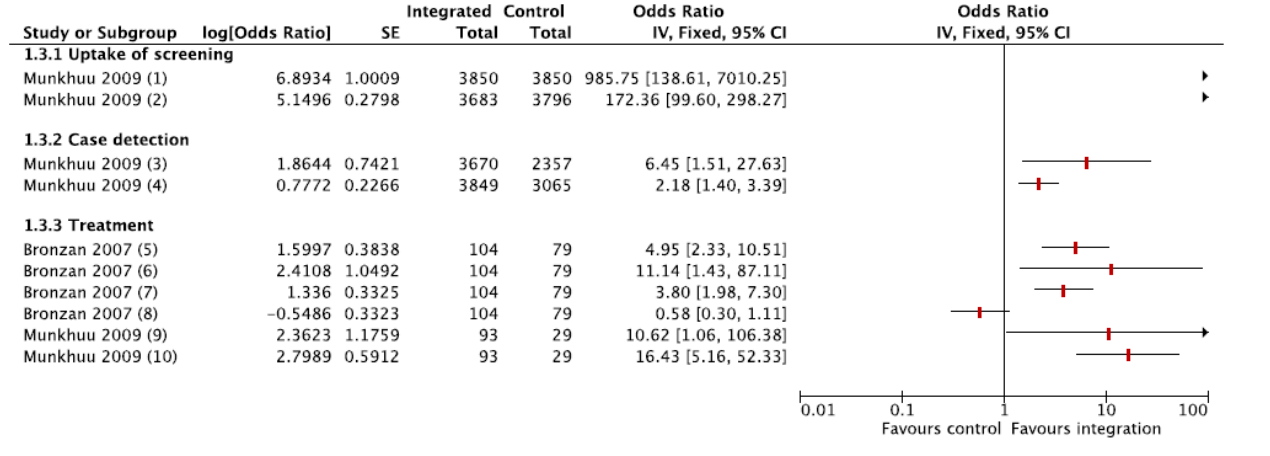
Figure 3. Uptake and utilization of syphilis screening services (integrated care vs controls). (1) Coverage at 1st antenatal visit; (2) Coverage at 3rd trimester; (3) Cases at 1st antenatal visit; (4) Cases at 3rd trimester; (5) At least one appropriately timed penicillin dose/week; (6) One appropriately timed penicillin dose/week; (7) Two appropriately timed penicillin doses/week; (8) Three appropri- ately timed penicillin doses/week; (9) Adequate treatment; (10) Partner